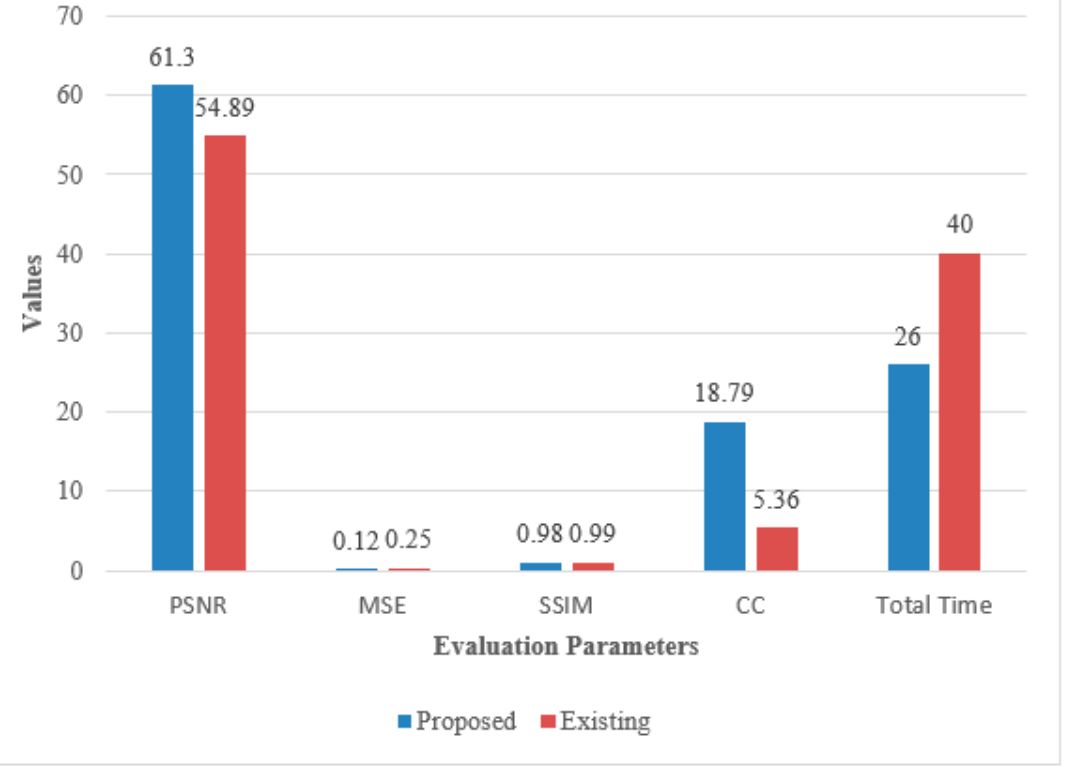
Figure 8. Comparison Chart.